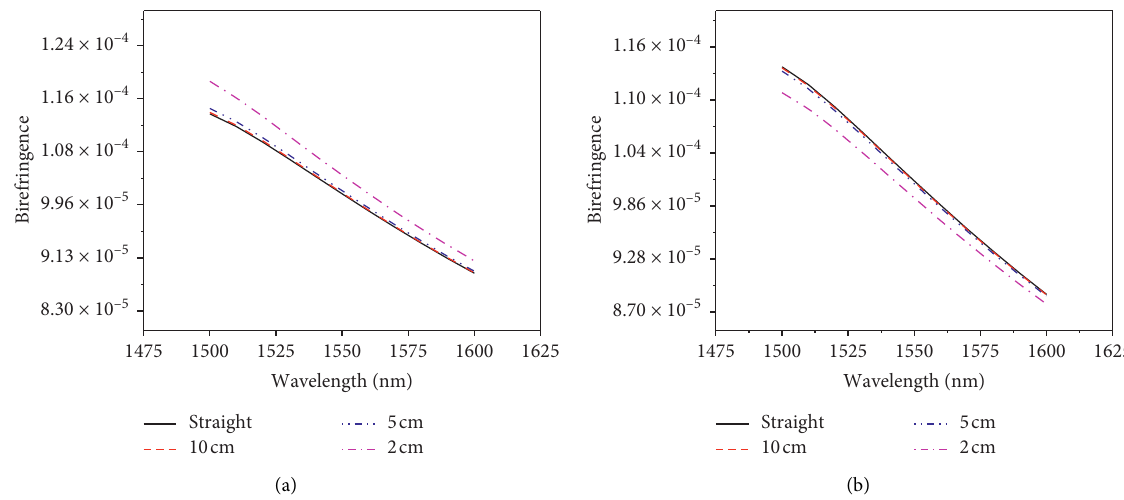
Figure 12: Birefringence of fiber in (a) x polarization and (b) y polarization as a function of wavelengths at different bending radii.